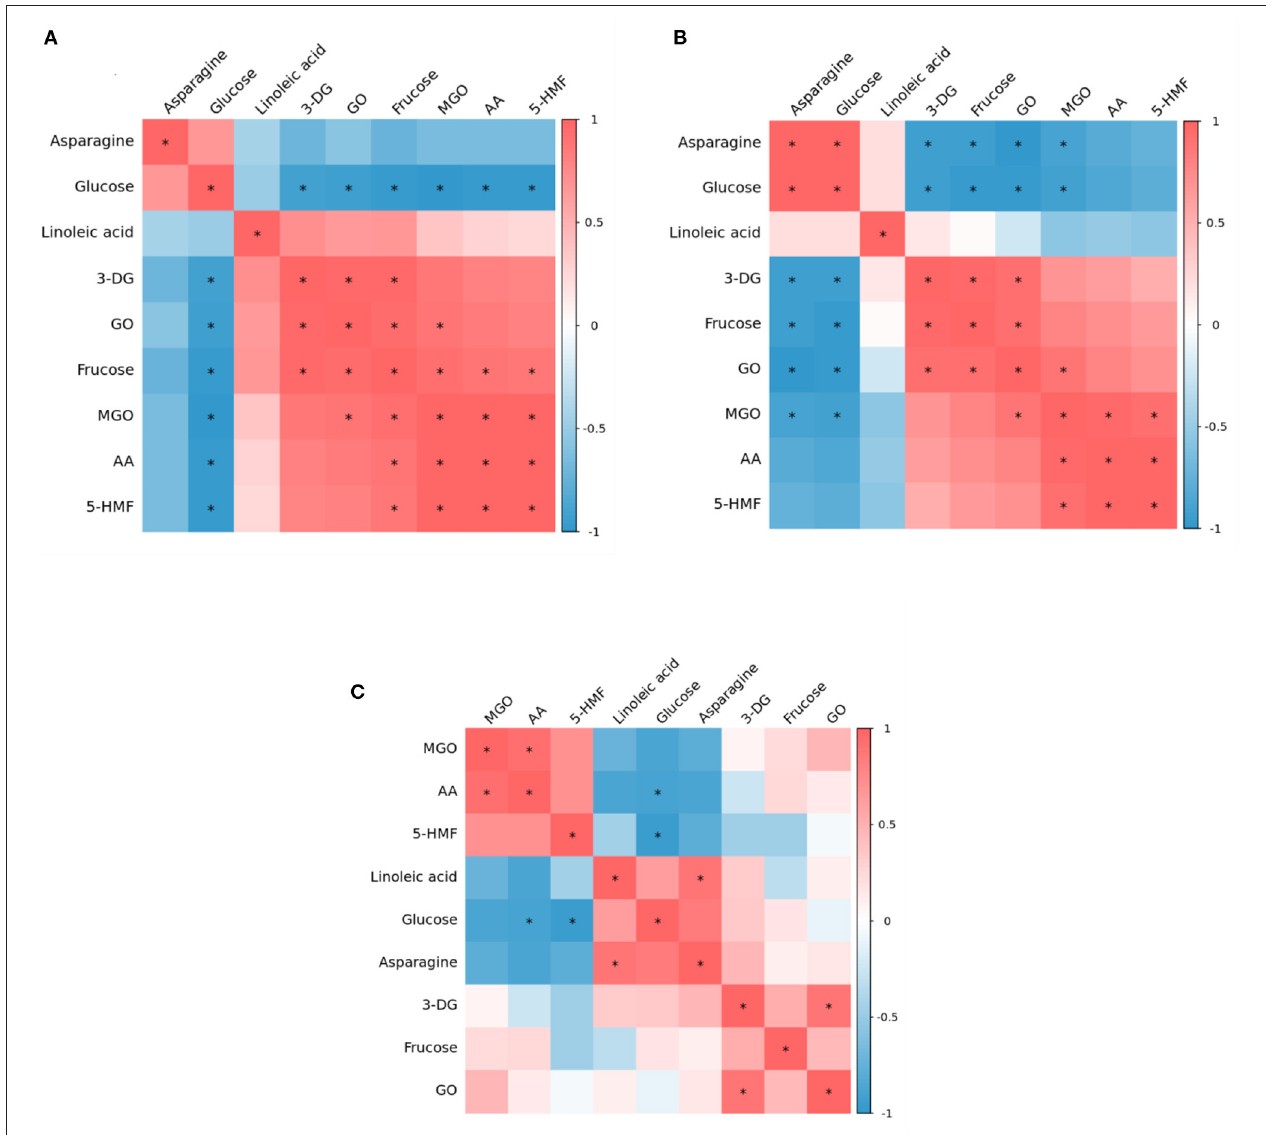
FIGURE 4 | Correlation heat map among precursor, intermediates and contaminants in heated model system (A) 160 ◦ C, (B) 180 ◦ C, and (C) 200 ◦